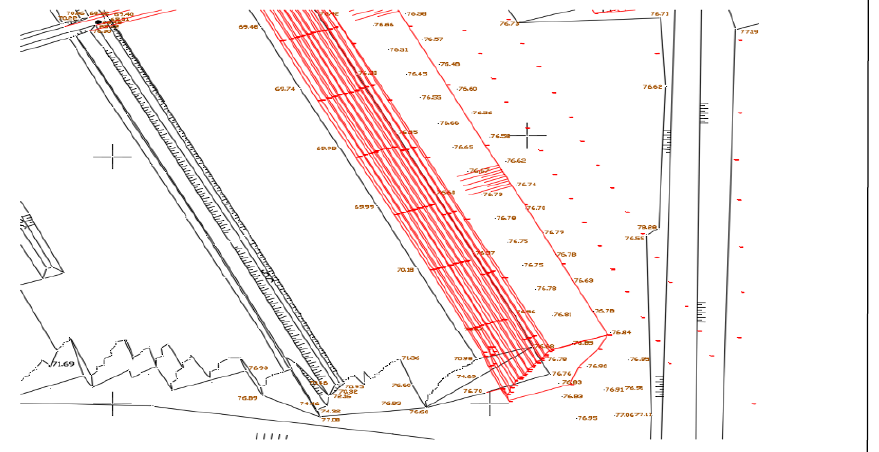
Figure 8 – Construction of the structural (course and ridge) lines Рис . 8 – Проектирование структурных линий